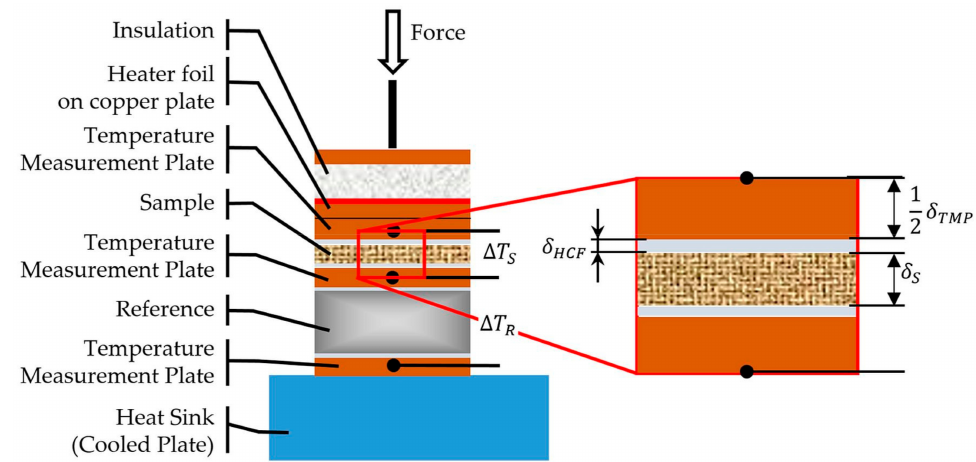
Figure 5. Schematic drawing of the steady-state plate method and detail of sample